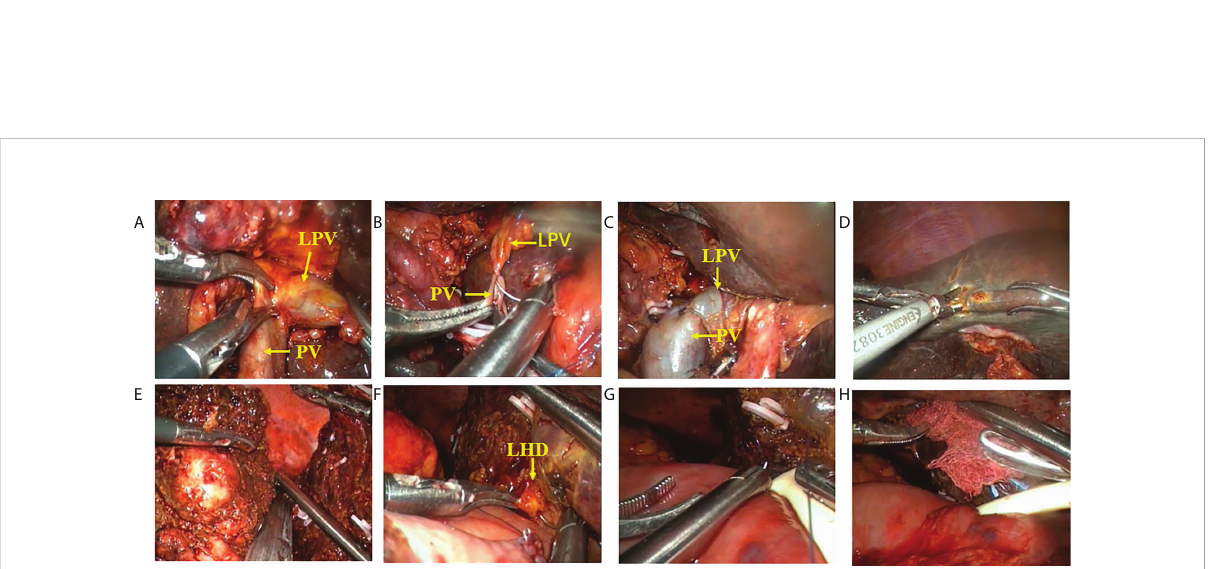
FIGURE 3 Procedure of laparoscopic hilar cholangiocrinoma 2. (A – C) resection and reconstruction of left branch of portal vein; (D) liver parenchyma transection-priority approach for liver resection; (E) transection of right hepatic vein using a cutter/staple; (F – H) hepatobliary duct-jejunum anastomosis (placement of T tube). LPV, Left branch of portal vein; PV, Portal vein; LHD,left hepatic duct.